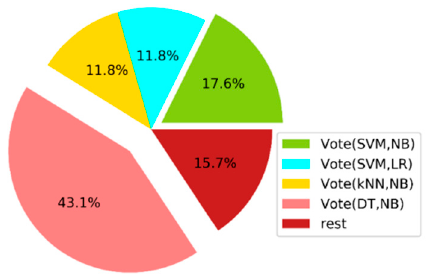
Figure 1. Pie chart depicting the participation of each combination inside our Static Ensemble strategy.